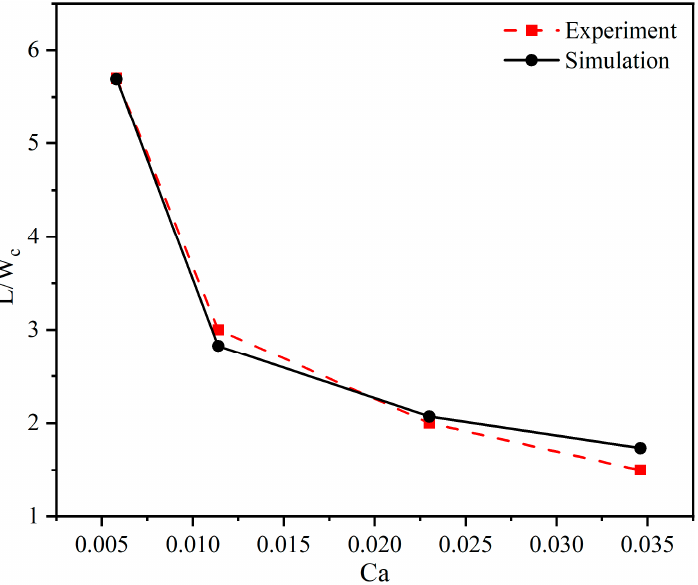
Figure 3. Comparison of numerical results of dimensionless microbubble size with experimental results.